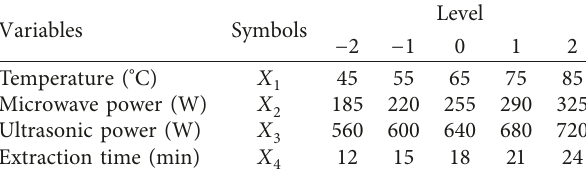
Table 3: Variance analysis of the regression